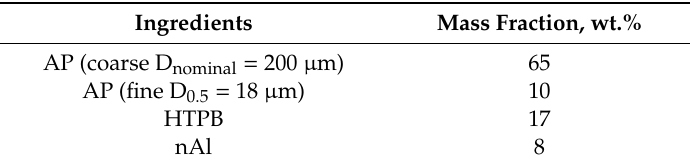
Table 3. Base composition of the propellants tested.